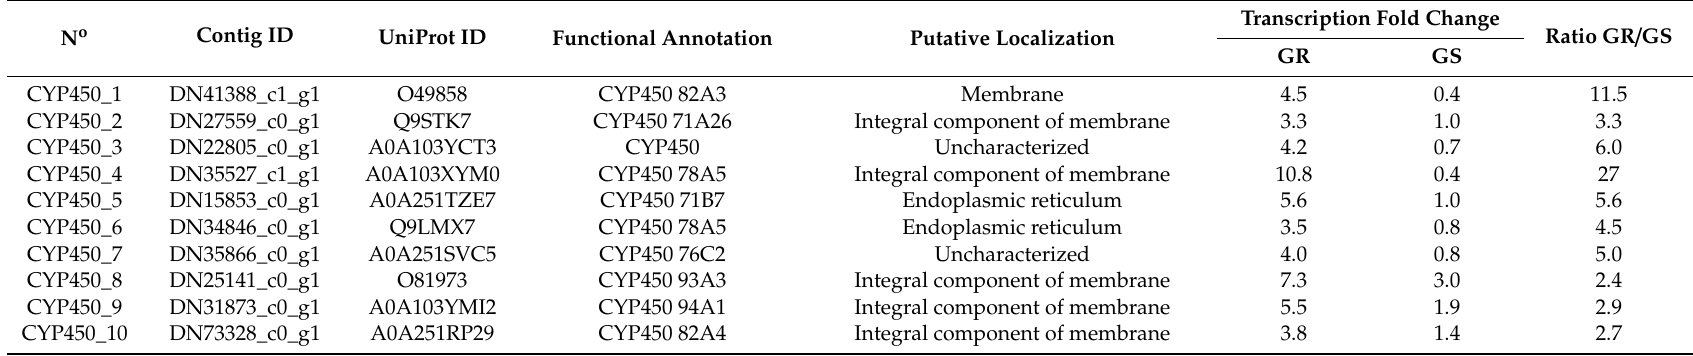
Table 2. Di ff erential expression of cytochrome P450 (CYP450) genes via RNA-Seq analysis of glyphosate-resistant (GR) and -sensitive (GS) C. bonariensis biotypes in